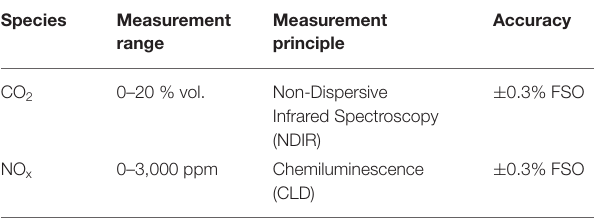
TABLE 1 | Specifications of the vehicles tested. TABLE 2 | Specifications of the Horiba OBS-ONE Gas